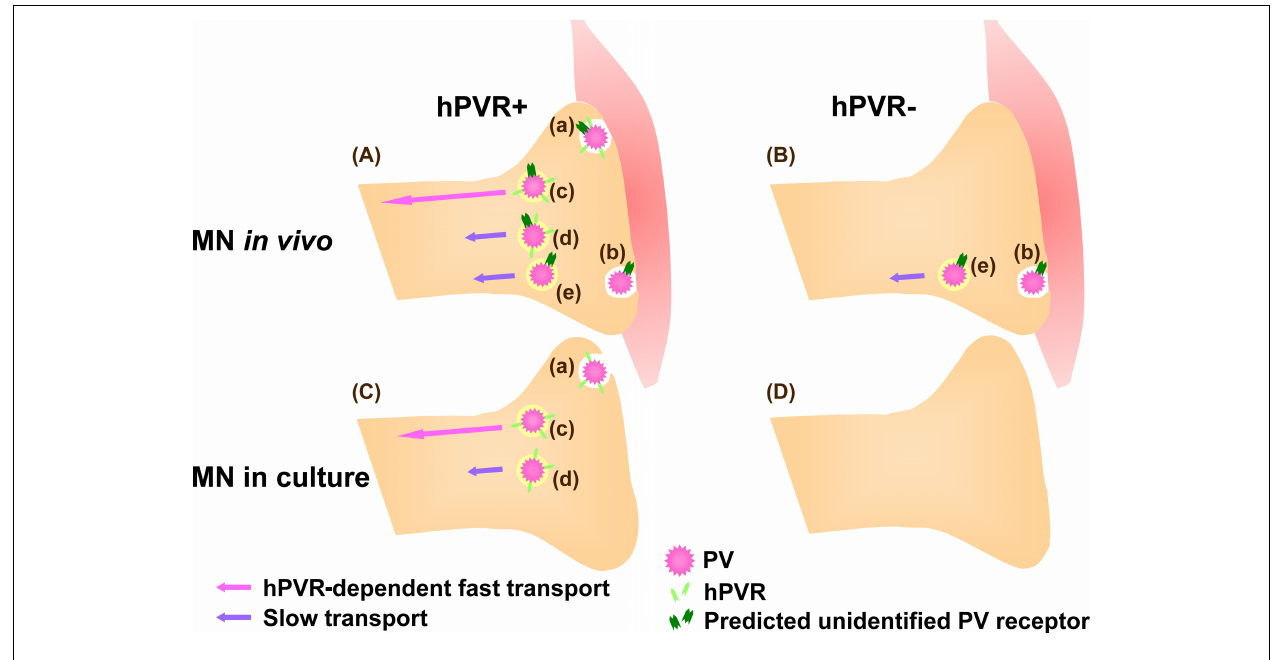
(Ad and Ae) . (B) In non-Tg mice, PV is endocytosed and transported with slow kinetics in an hPVR-independent manner (Be) .The hPVR-independent endocytosis is possibly mediated by the unidentified PV receptor expressed at neuromuscular junctions (Bb) . (C) In cultured MNs, only hPVR-dependent PV endocytosis is detected (Ca) .The hPVR-dependent transport shows fast kinetics (Cc) . It might be possible that the slow component in cultured MNs (Cd) requires hPVR for endocytosis, whereas its transport may be hPVR-independent. (D) No endocytosis of PV is detected in cultured MNs lacking hPVR, possibly due to the absence of the unidentified PV